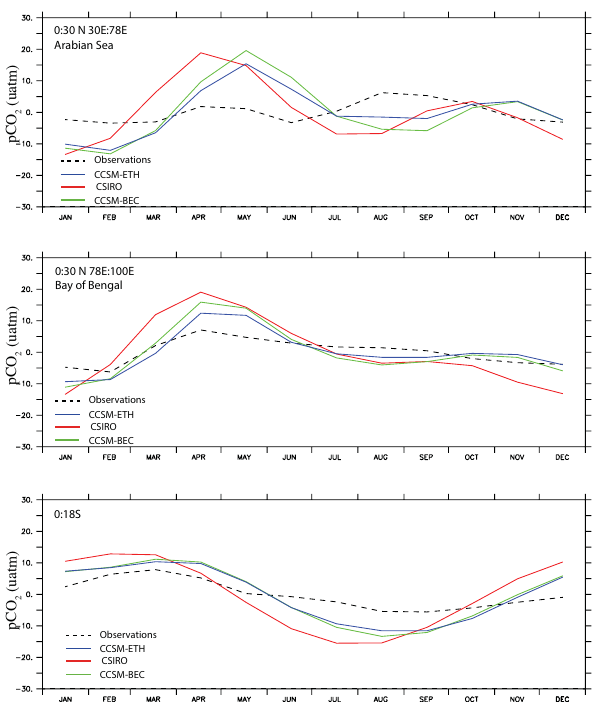
Fig. 9. Seasonal cycle p CO 2 anomaly for parts of the northern In- dian Ocean (µtam) from observations and ocean biogeochemical models: the Arabian Sea (0–30 ◦ N, 30–78 ◦ E; upper), the Bay of Bengal (0–30 ◦ N, 78–100 ◦ E; middle) and the area between 0 and 18 ◦ S (lower).